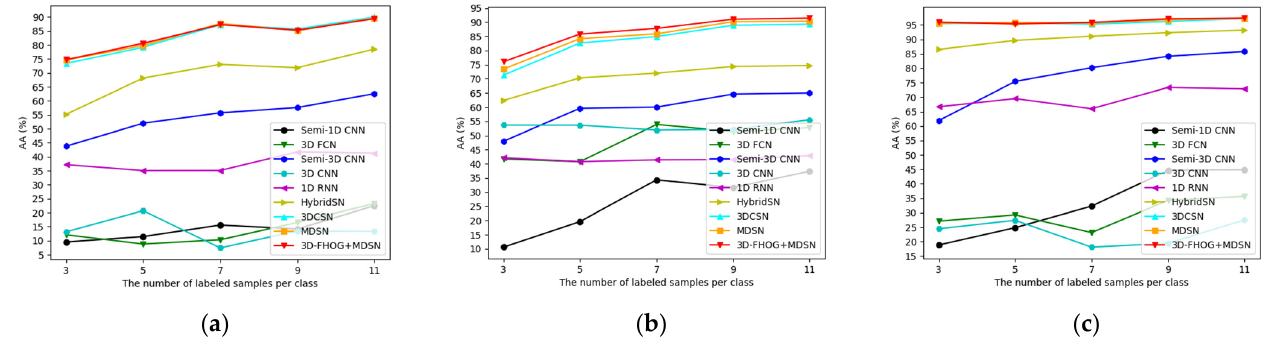
Figure 11. AA as functions of the number of labeled samples per class on three test data sets: ( a ) IP data set; ( b ) PU data set; ( c ) SA data set.